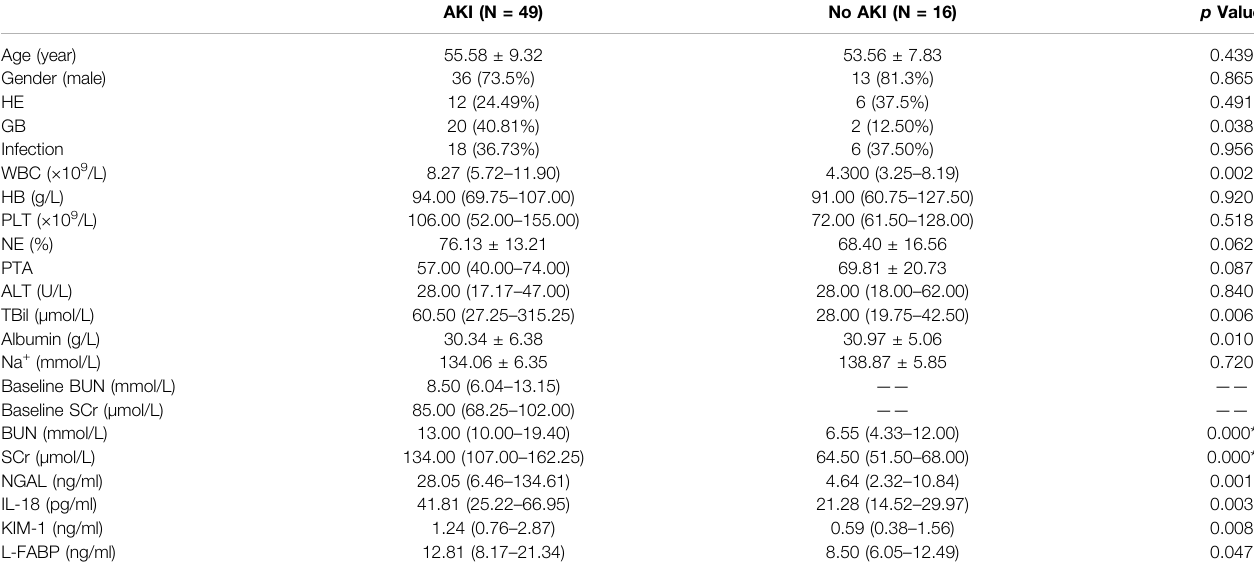
TABLE1 | Baseline characteristics of patients with and without AKI in